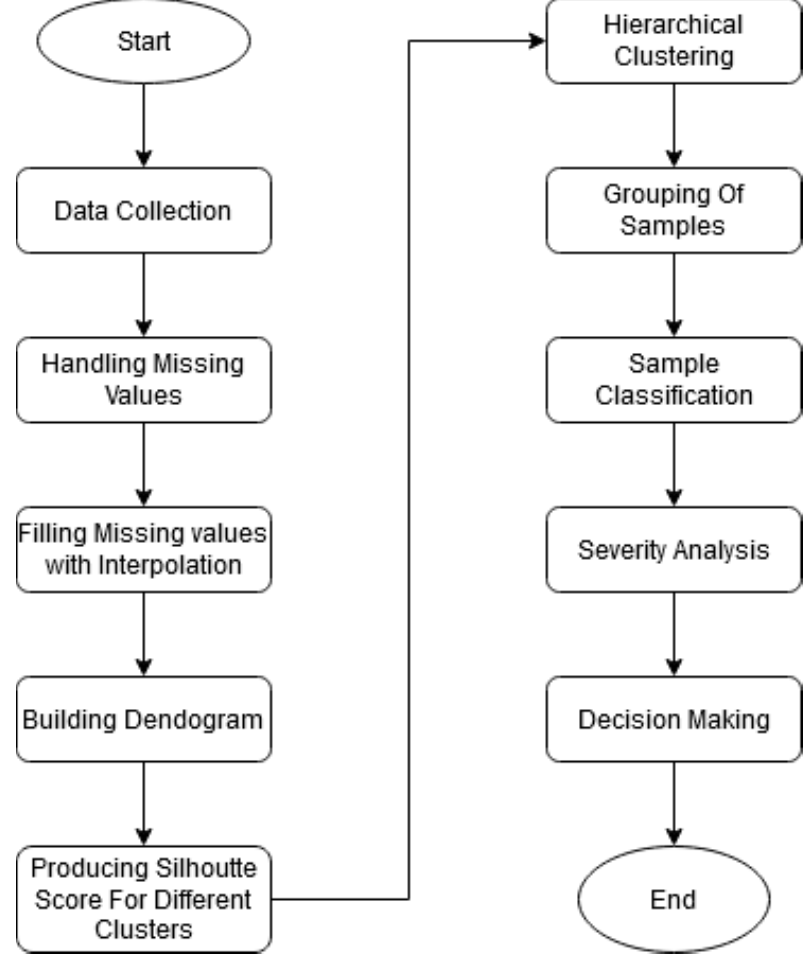
Figure 5. Top level overview of the dengue prediction model (BDengue